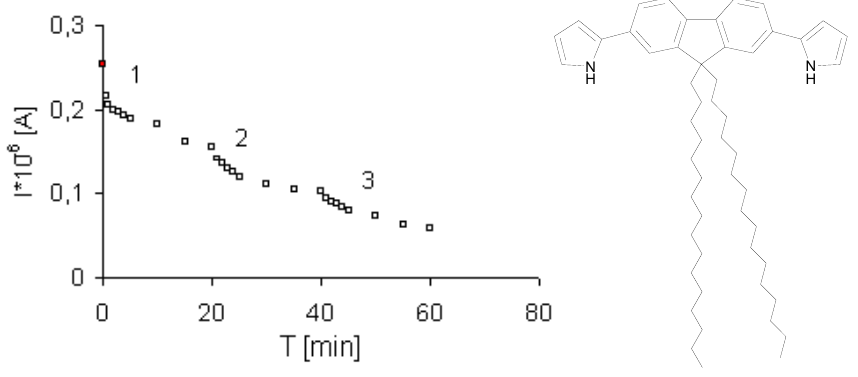
Figure 4. Response of a one LB layer thick sensor 1 to increasing concentrations of NH during 60 minutes. In each step, the NH the initial signal as red point [30].